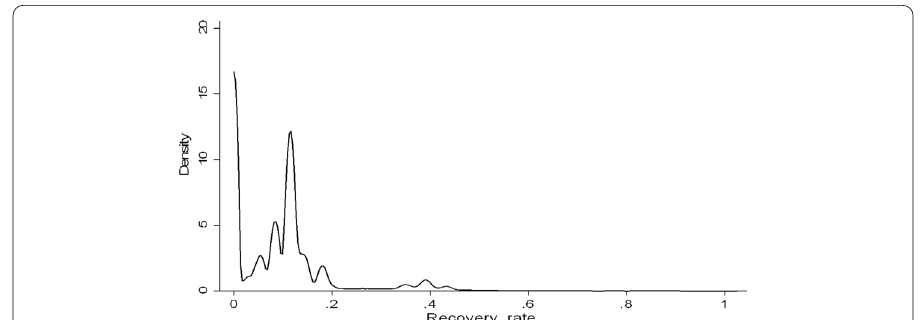
Fig. 7 Kernel density of recovery rates in the sample. Notes. This graph shows the density distributions of the recovery rates on defaulted loans in the sample. The stack of 0 s shows the frequency of RR not unimodal distribution